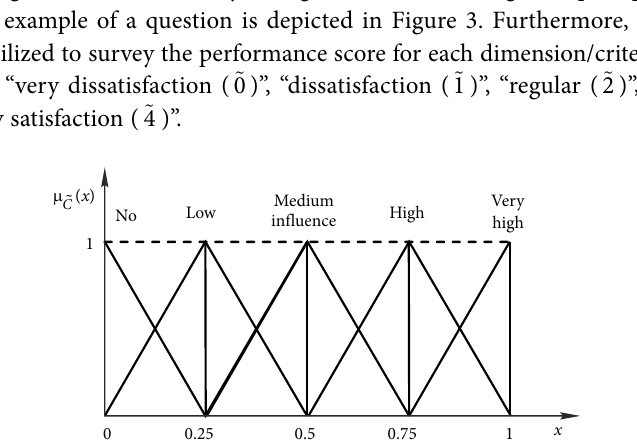
Figure 3. Membership functions of fuzzy linguistic scale